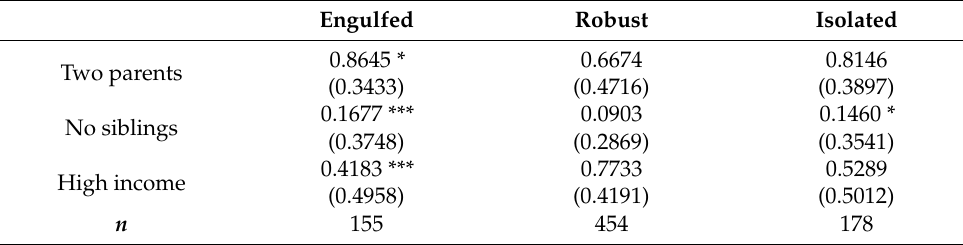
Table 2. Description of types of student and family background.